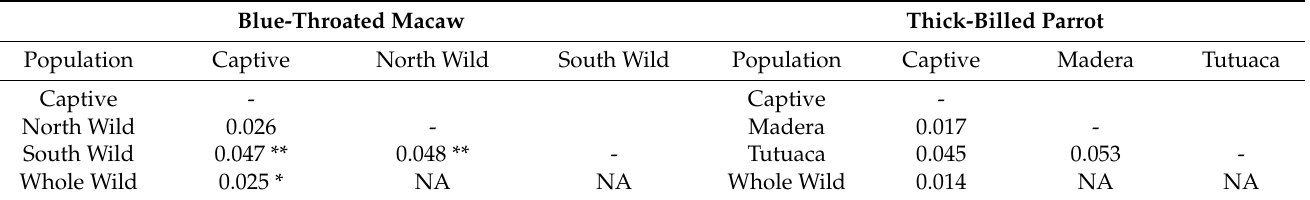
Table 1. Pairwise Fst values for the blue-throated macaw and thick-billed parrot. p -values denoted by: * = p -value < 0.05; ** = p -value < 0.016. NA denotes comparisons that cannot be made between a population and one of the subpopulations that compose